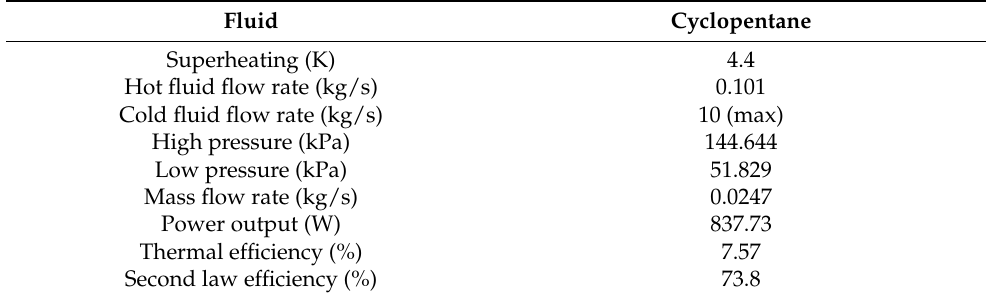
Table 6. Optimized ORC design for the PEM fuel